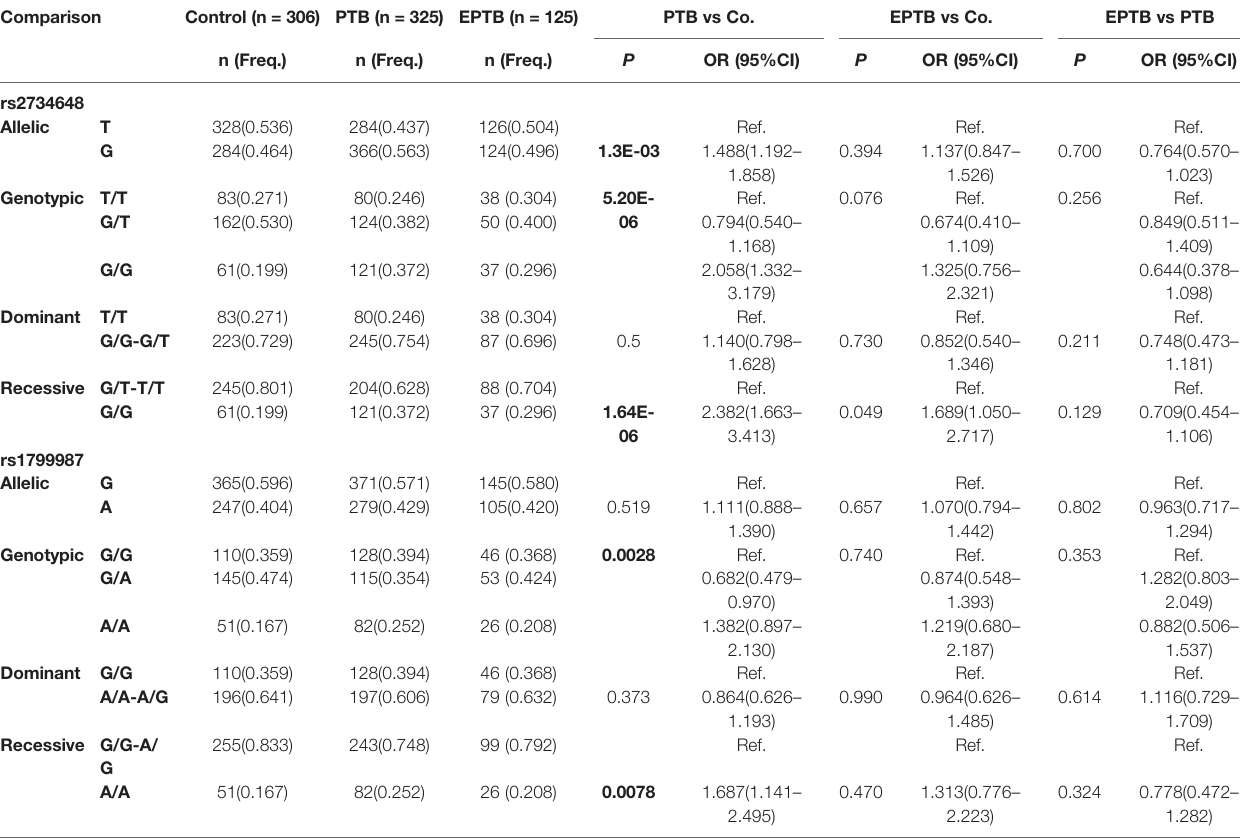
TABLE 3 | Strati fi cation analysis on the association between CCR5 promoter SNPs and clinical TB phenotypes.